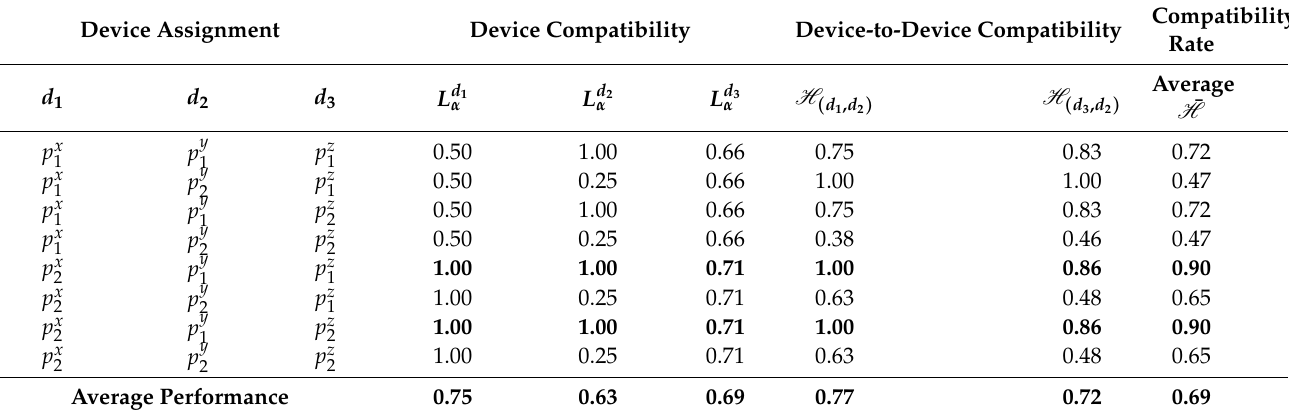
Table 4. Evaluation of compatibility rate for a sample group of physical